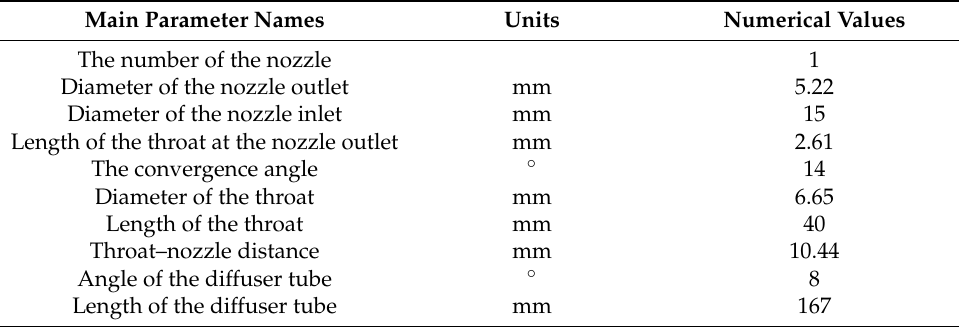
Table 3. Specific parameter values of key structures in the new jet